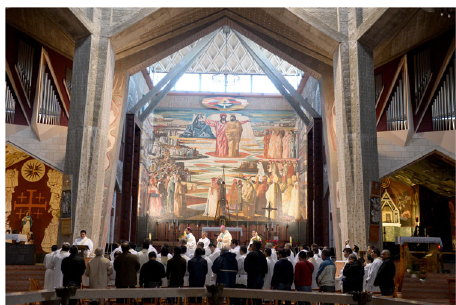
Fig. 6 Salvatore Fiume ’ s mosaic in the Basilica of the Annunciation ’ s upper church (Photographer unknown, 2013, National Photo Collection, Photography Department, Government Press Of fi ce, State of